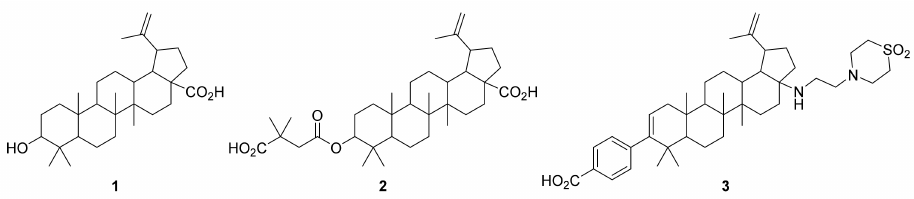
Figure 1. Chemical structures of BA ( 1 ) and the relevant synthetic BA derivatives bevirimat ( 2 ) and BMS-955176 ( 3 ).